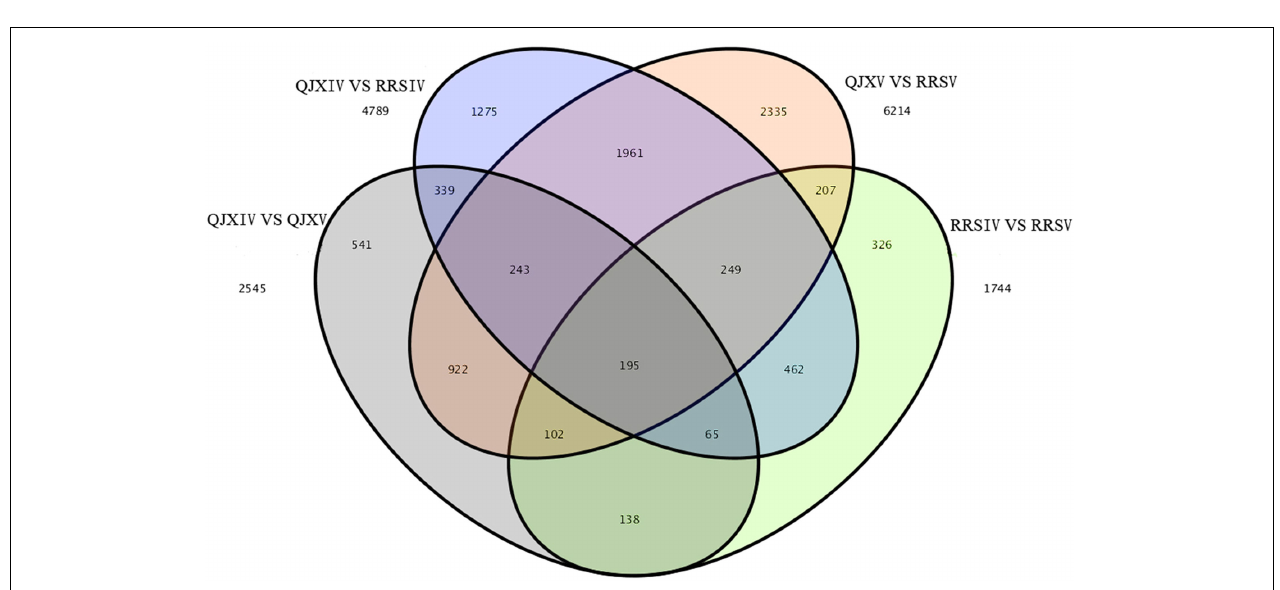
FIGURE 4 | Venn map showing the unique and shared unigenes with significantly different expression levels in ‘Ruanrou Shanlihong 3 Hao’ and ‘Qiu JinXing’ fruits at two developmental stages.